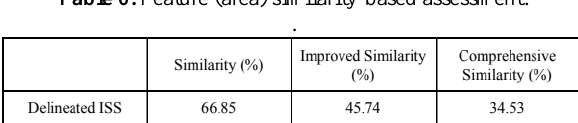
Table 6. Feature (area) similarity-based assessment.